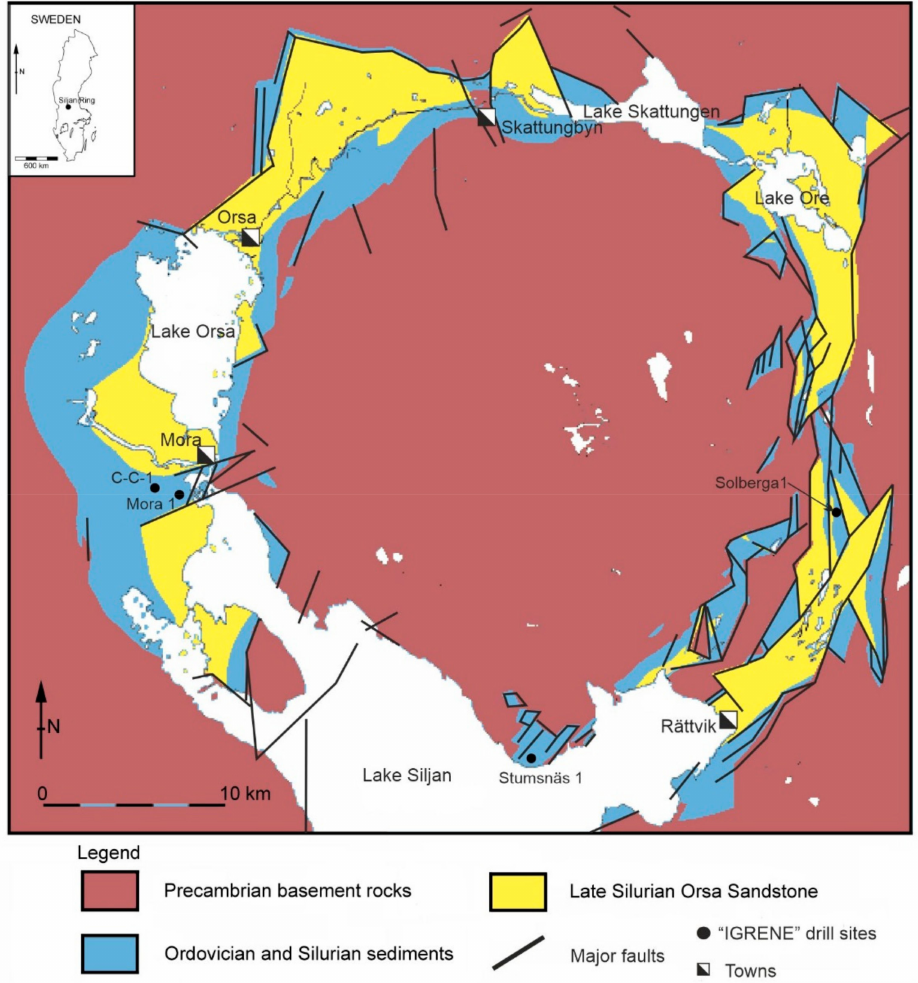
Figure 1. Simplified geological map of the Siljan Ring structure, showing the locations of “IGRENE” drill